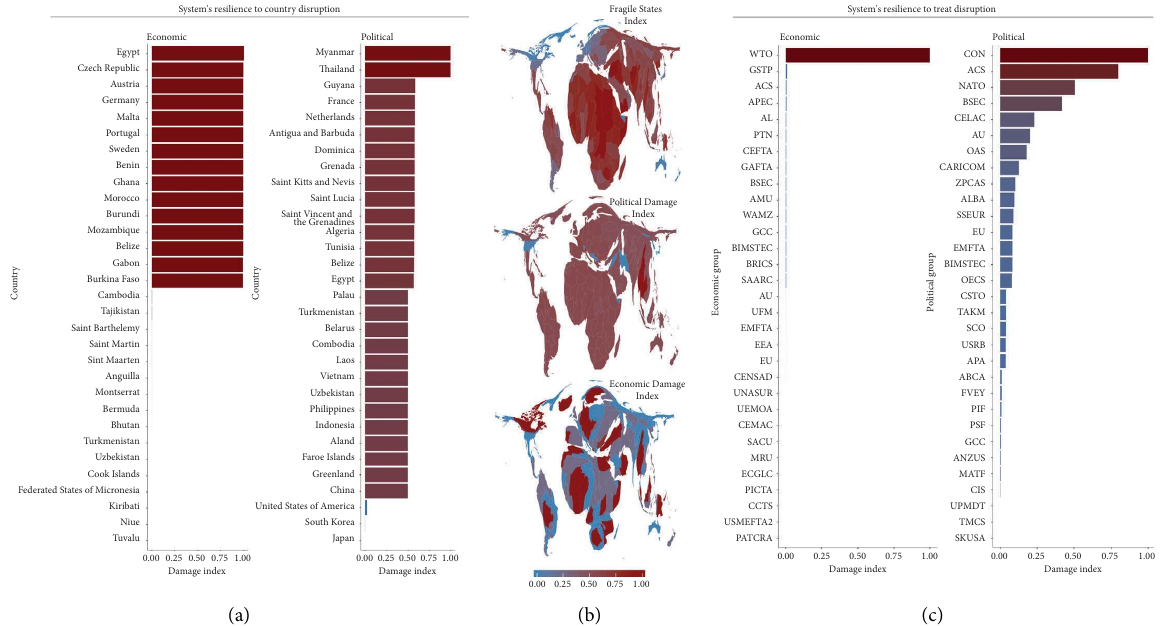
Figure 2: Cartography of world order resilience. Te central panel shows the distorted maps of the fragile states index (FSI, top) vs. the political damage index (PDI, middle) and economic damage index (EDI, bottom), as defned in the text. Cartograms are built according to Gastner and Newman (33). In the left and right panels, we show the values of the damage index with respect to economic and political relationships, separately, in response to country-based disruptions (left) and treat-based disruptions (right): values range from 0 to 1, and we refer to the text for further